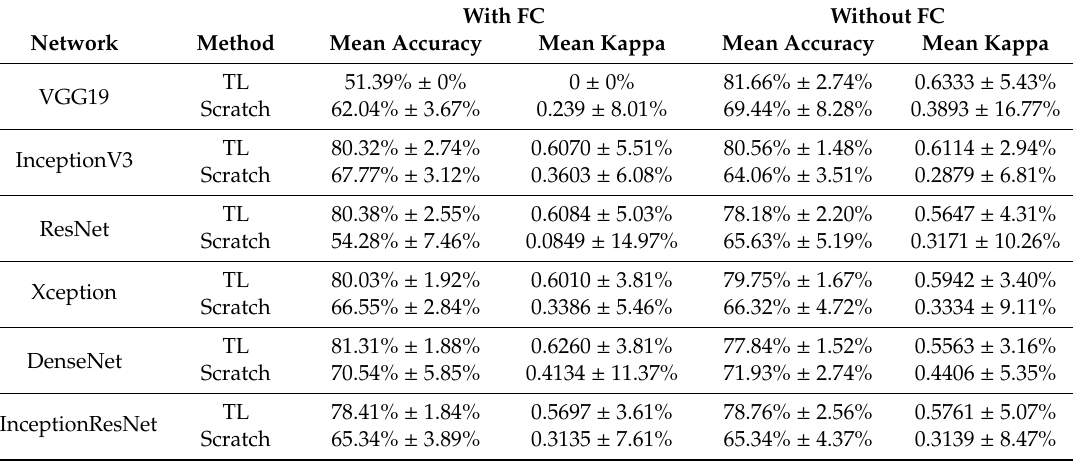
Table 5. Accuracy and Kappa scores of classifying humerus images with and without fully connected layers ( ± 95%